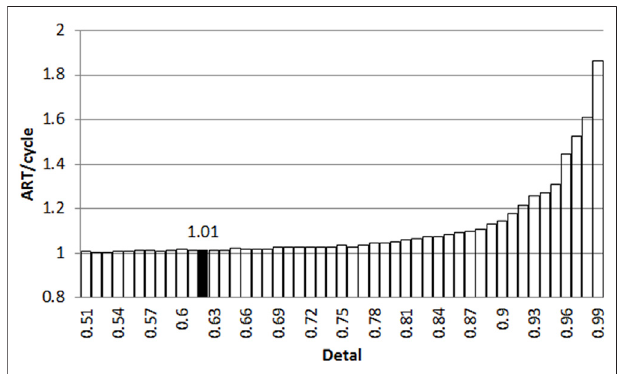
FIGURE 10 | δ on the relationship of ART